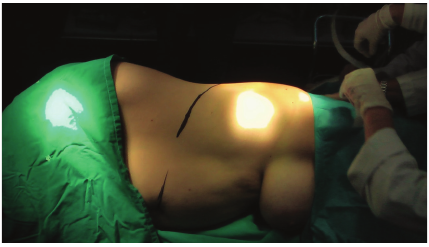
Figure 3: Patient at left side, posterolateral extraperitoneal incision was made to approximate the tumor.